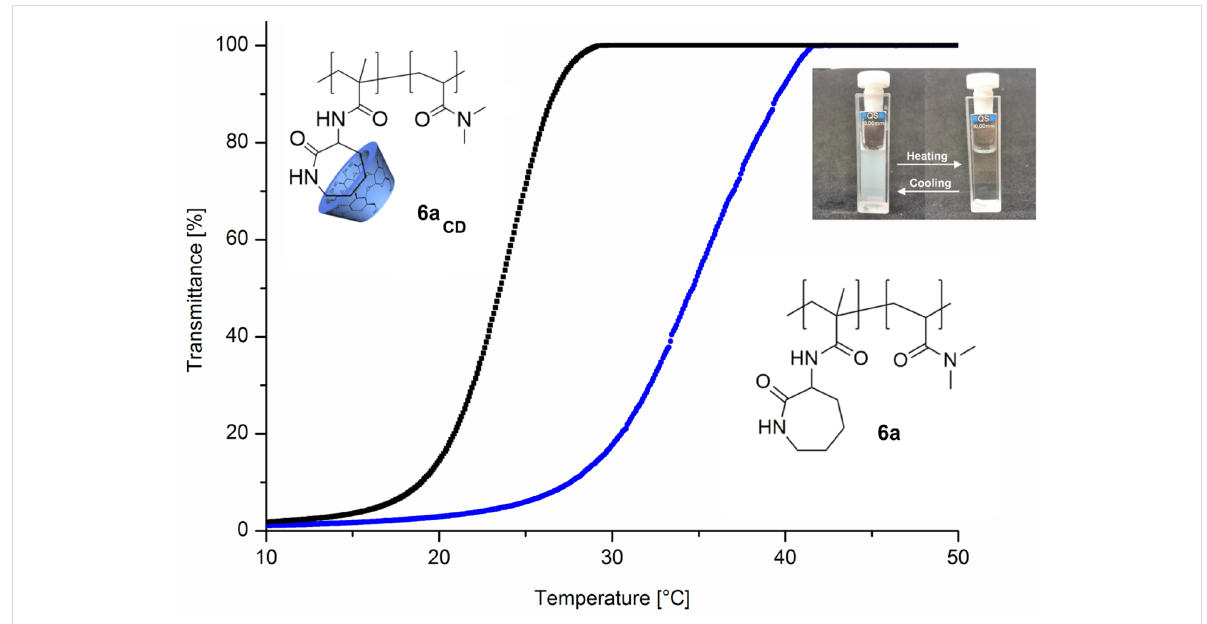
Figure 4: Turbidity curves upon cooling of 10 mg ml − 1 solution of polymer 6a and 6a CD at a cooling rate of 1 °C min − 1 in ethanol.